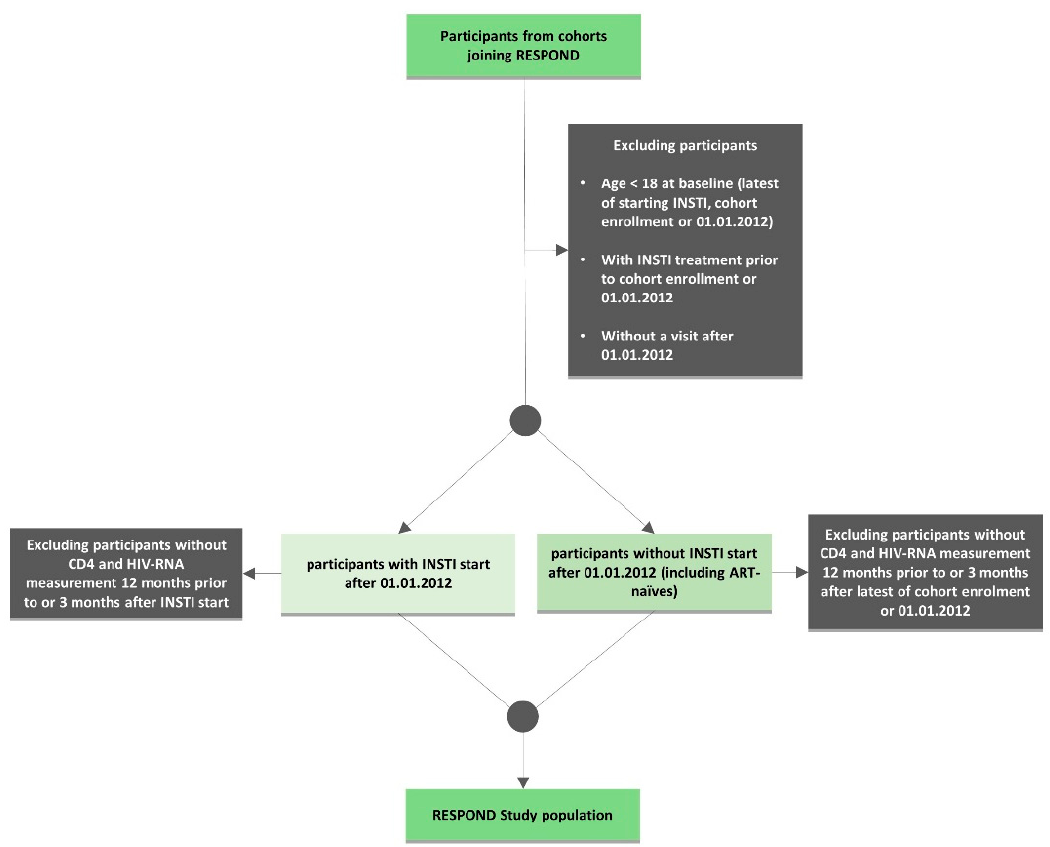
Figure 1. Flowchart of the International Cohort Consortium of Infectious Disease (RESPOND) inclusion and exclusion criteria.